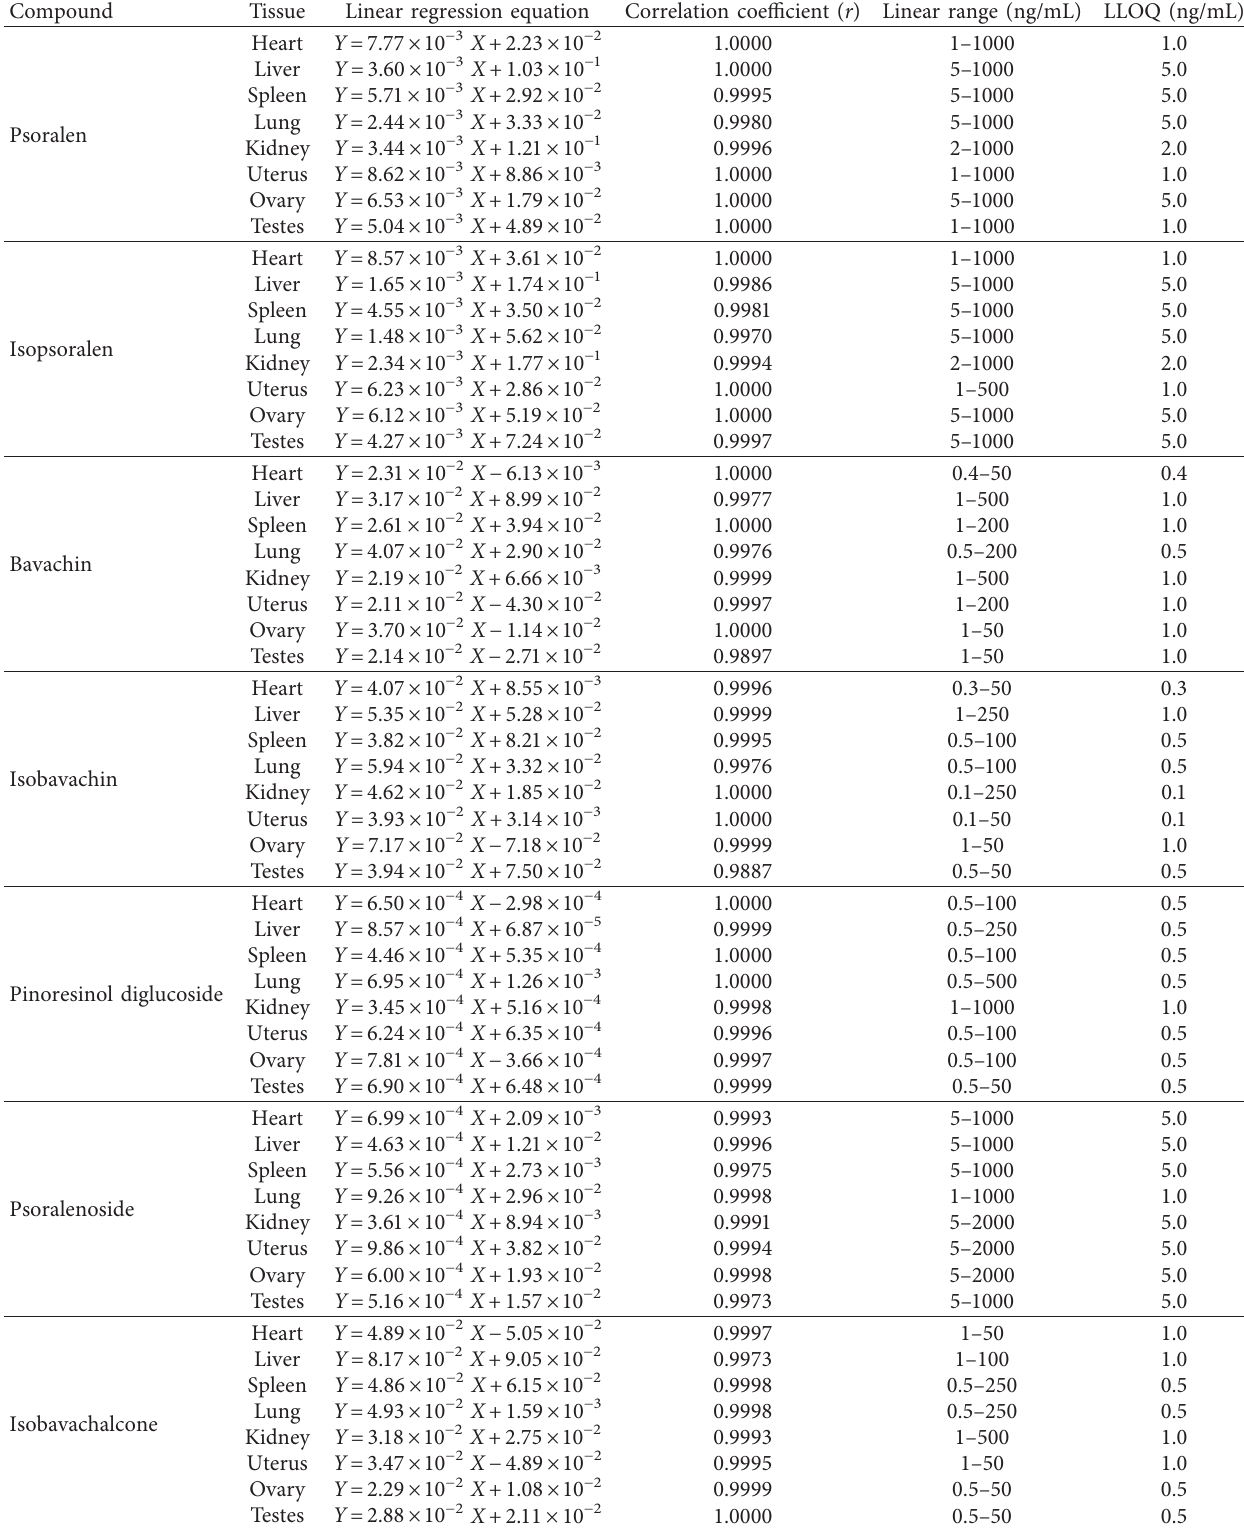
Table 2: Calibration curves, correlation coefficient, linear range, and LLOQ of 12 compounds.